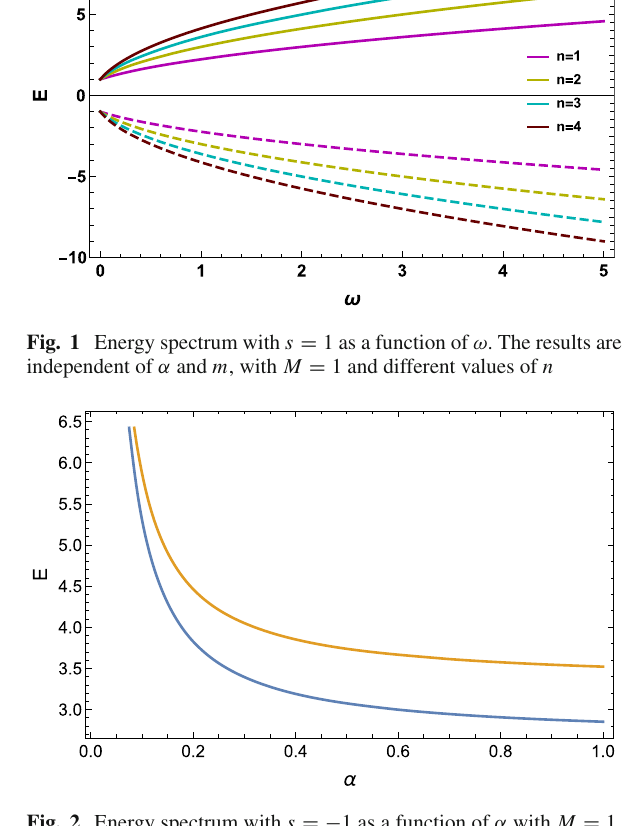
Fig. 2 Energy spectrum with s = − 1 as a function of α with M = 1, m = 1 / 2, a = 0 . 1 and ω = 1 for n = 1 (blue) and n = 2 (dark yellow)